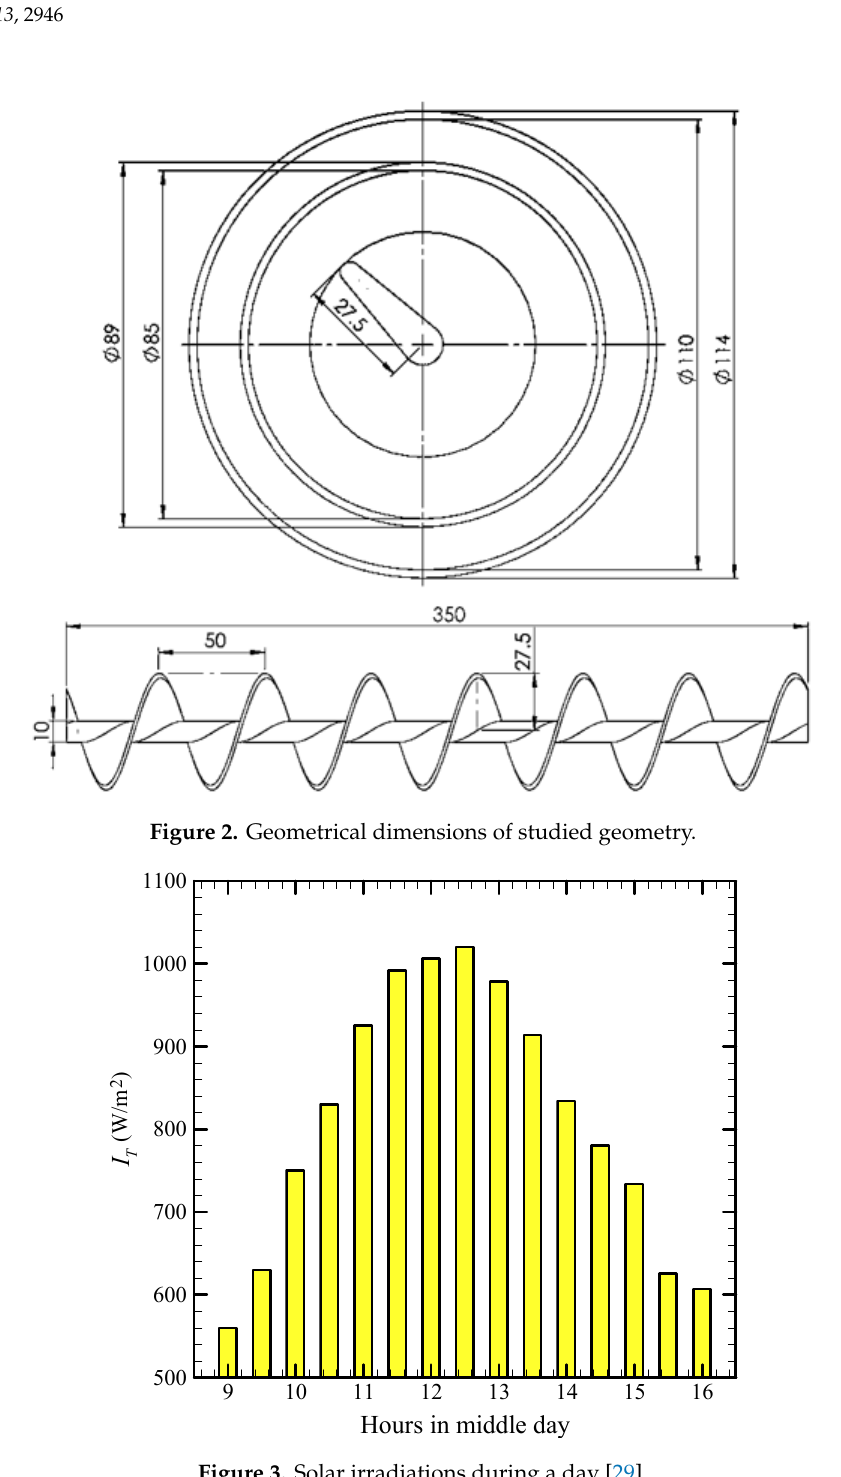
Figure 3. Solar irradiations during a day [29].